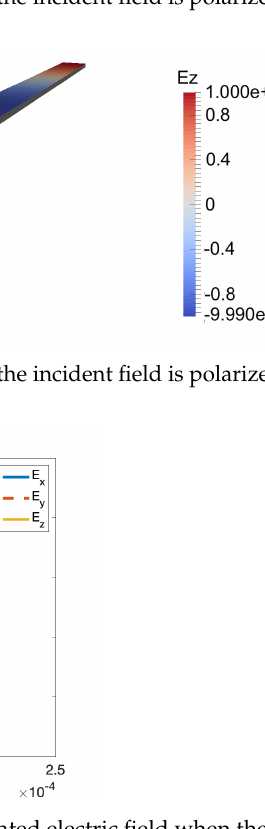
Figure 8. Through-the-thickness-simulated electric field when the incident field is polarized in the direction of the fibers for ω 1 = 2.45